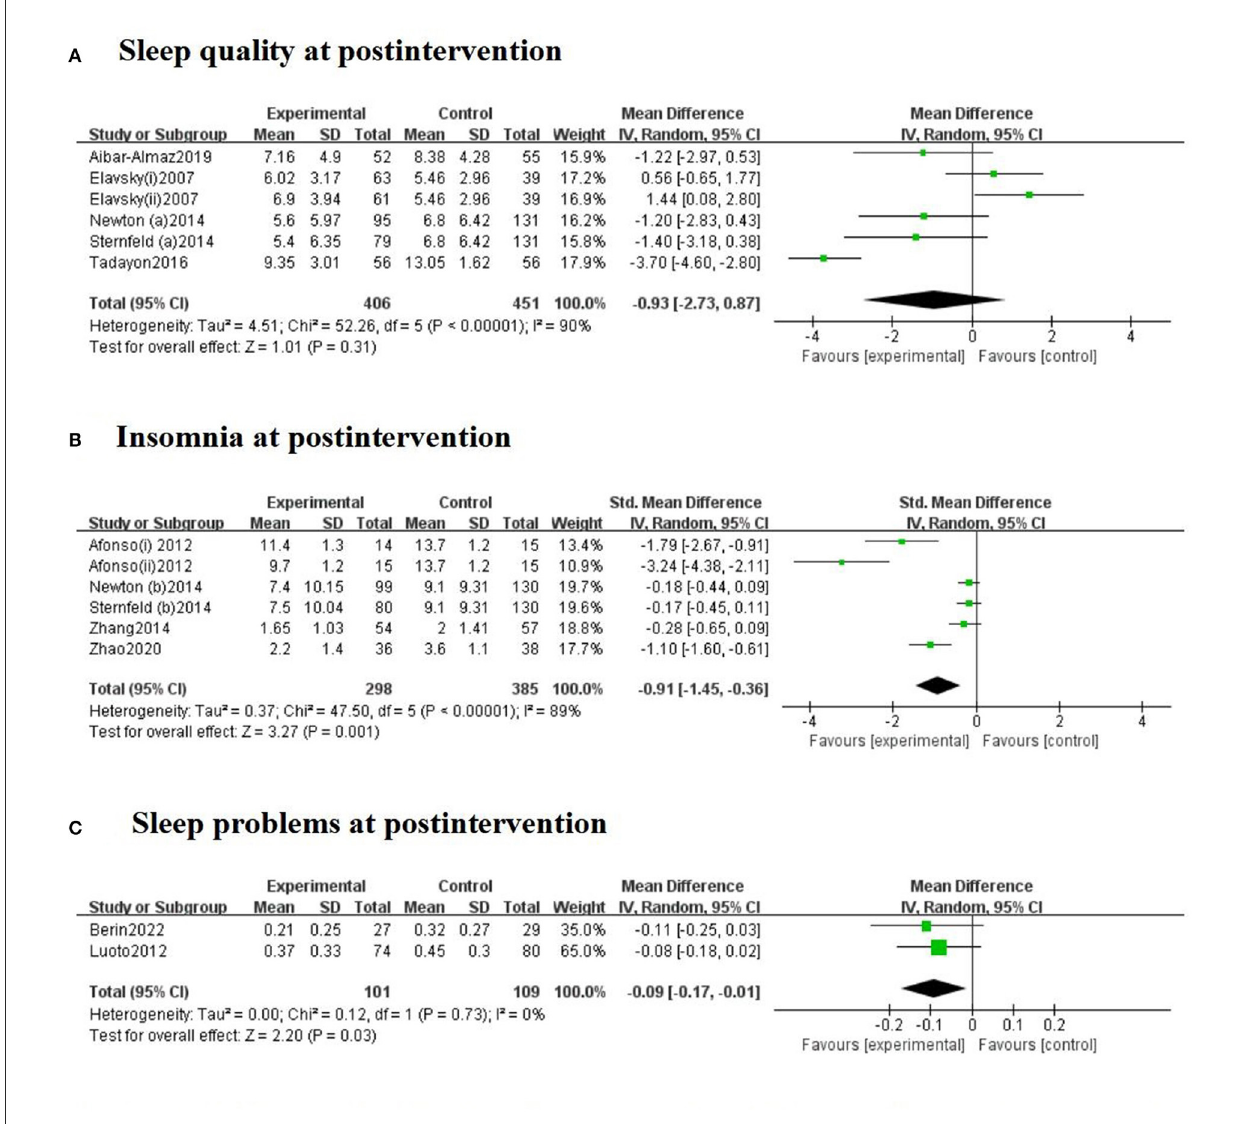
FIGURE2 Forest plots for the effect of exercise training on sleep quality (A) , insomnia (B) , and sleep problems (C) at postintervention. The Afonso et al. (42) study included two intervention groups (i: passive stretching and ii: yoga), which had assessment scores. The Elavsky and McAuley (22) study included two intervention groups (i: walking and ii: